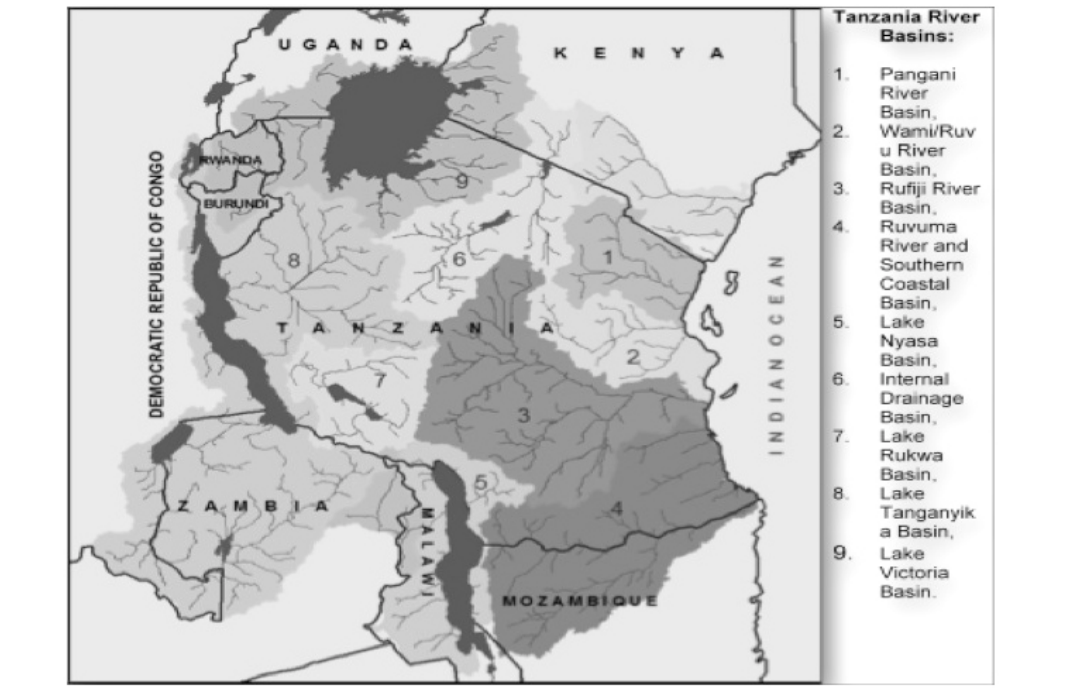
Fig. 1. Map of Tanzania, showing the nine major basins. Source: Tanzanian Ministry of